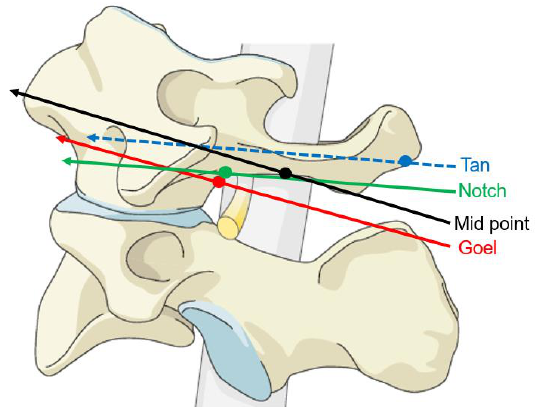
Figure 7. Lateral view of entry point and trajectory of four kinds of LMS placement. Blue line: Tan method, green line: Notch method, red line: Goel method, black line: mid-point method. Every circle indicates bony entry